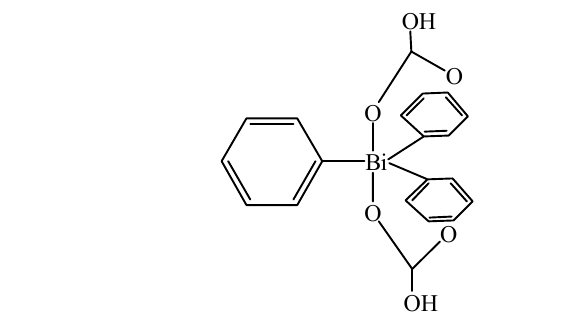
Figure 3. Bismuth(V) complex Bi V R